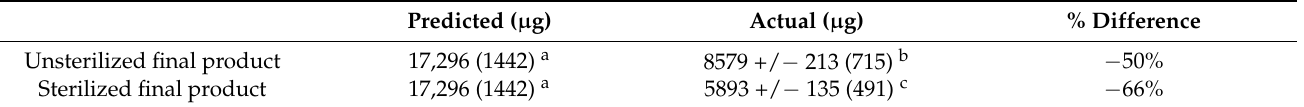
Table 4. Comparison of predicted β -carotene versus actual β -carotene content in the unsterilized and sterilized products. Predicted ( µ g) Actual ( µ g) % Difference Unsterilized final